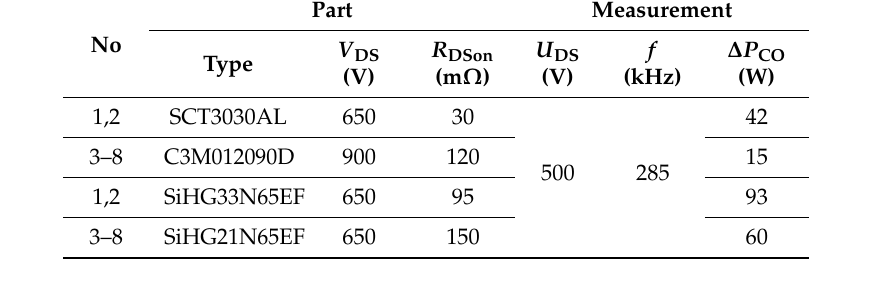
Table 2. The measured idle power of a single HB for different transistors used for the SiC and Si setup.